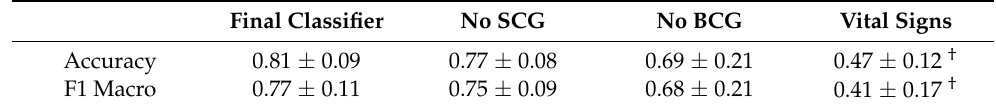
Figure 4. Time series sequences of multi-class blood volume decompensation state (normovolemia- relative hypovolemia-absolute hypovolemia) classification outcomes associated with all the animals in conjunction with the ground truth. Table 5. Comparison of final multi-class classifier and three competing ML classifiers (vital signs only, SCG-based features excluded, and BCG-based features excluded).